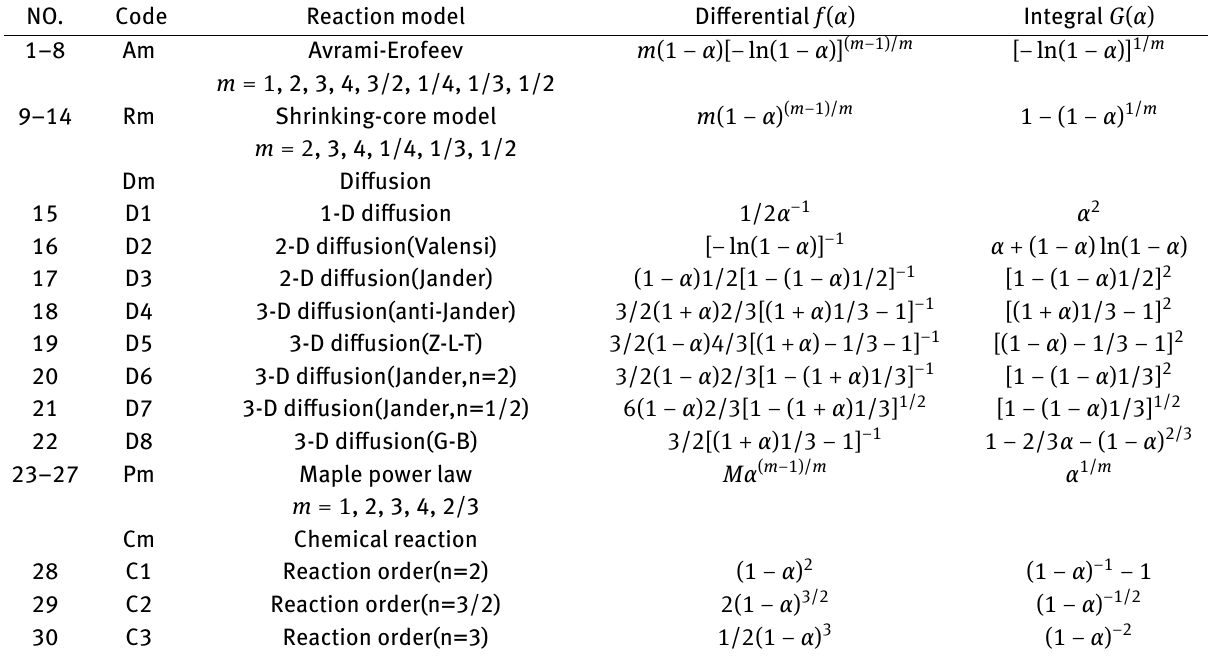
Table 3: Differential and integral expressions of common reaction conversion degree function